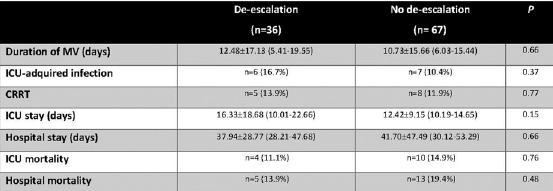
Table 2 (abstract 000935). See text for